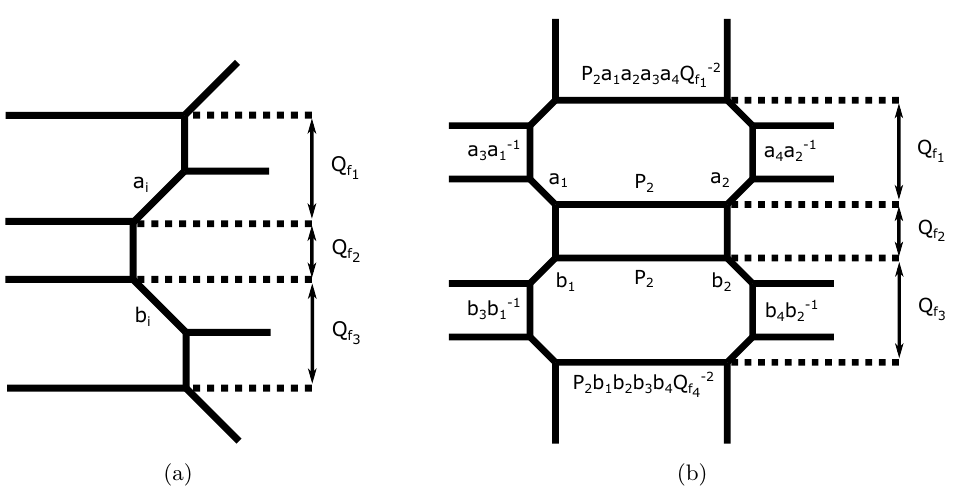
Figure 30. (a): A web diagram which describes a hypermultiplet in the bifundamental represen- tation between the SU(4) and an SU(2) in the affine D 4 Dynkin quiver theory (2.28). (b): A web diagram which describes the SU(4) 0 gauge theory with 8